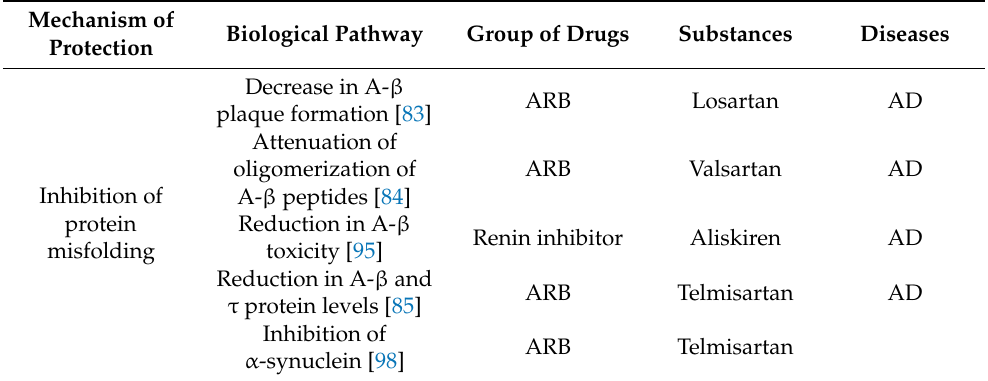
Table 4. Protective mechanisms of RAS pharmacological modulators via the inhibition of neuronal protein